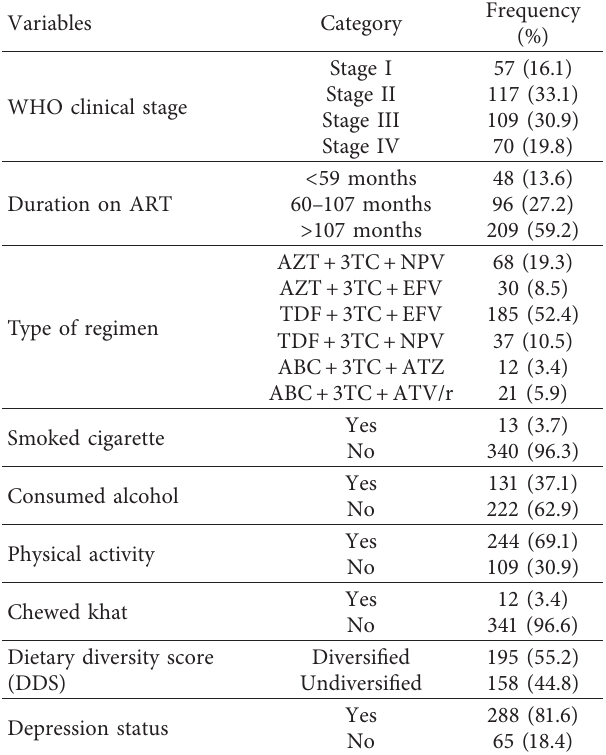
Table 2: Clinical and behavioral characteristics of HIV patients who received ART at armed force comprehensive and specialized hospital, Ethiopia, 2018 ( n �